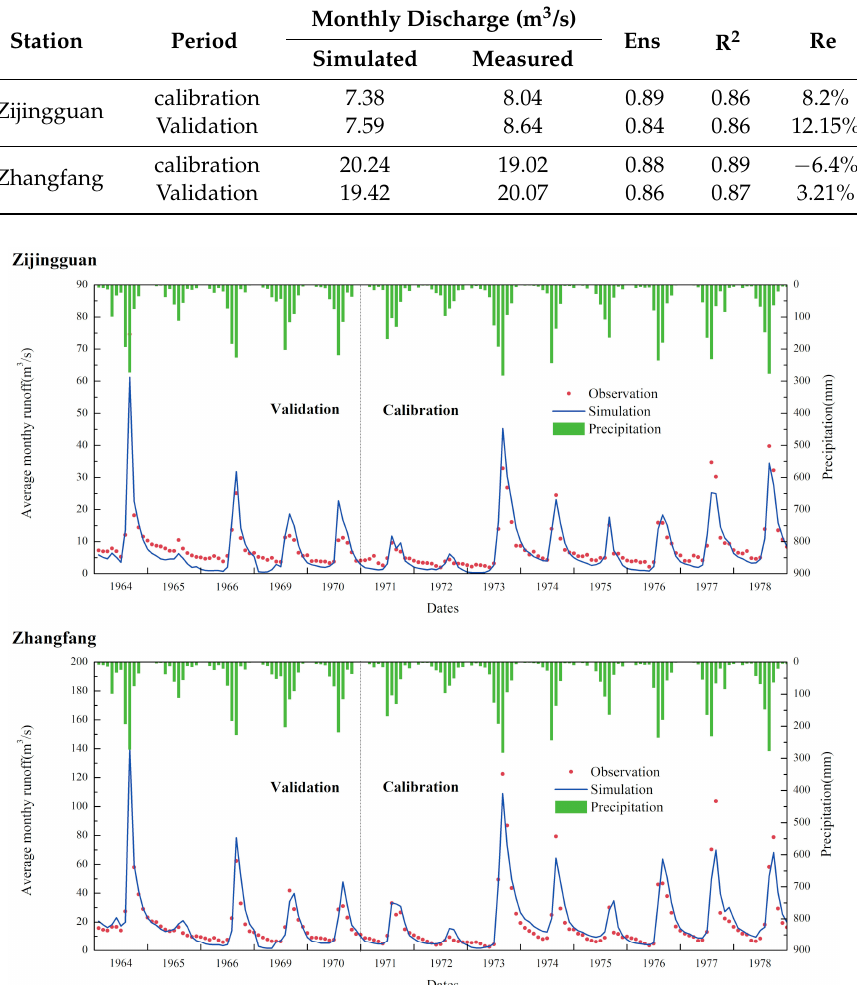
Figure 7. Comparison of the observed monthly runoff and simulated monthly runoff.